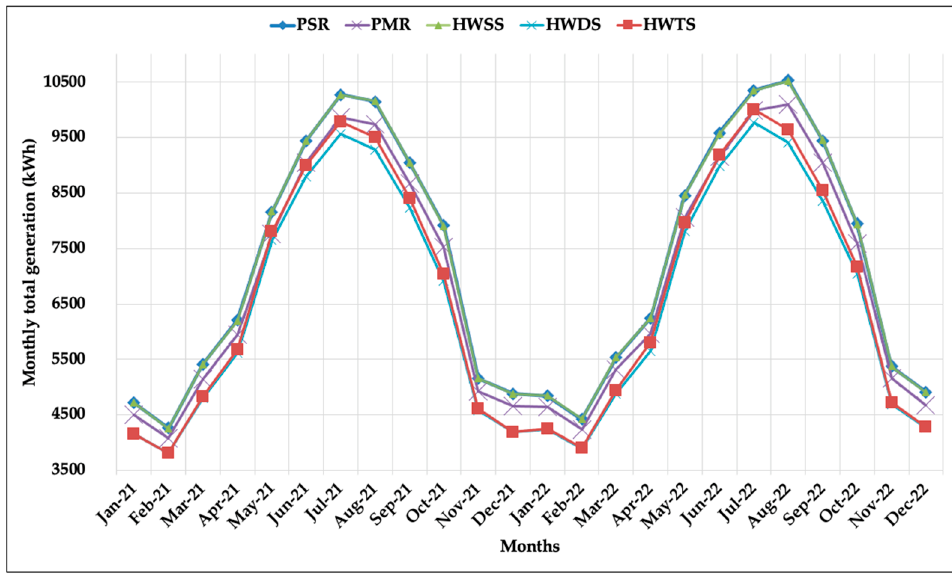
Figure 7. Monthly total generation of electricity for Kuwait between 2021 and 2022.